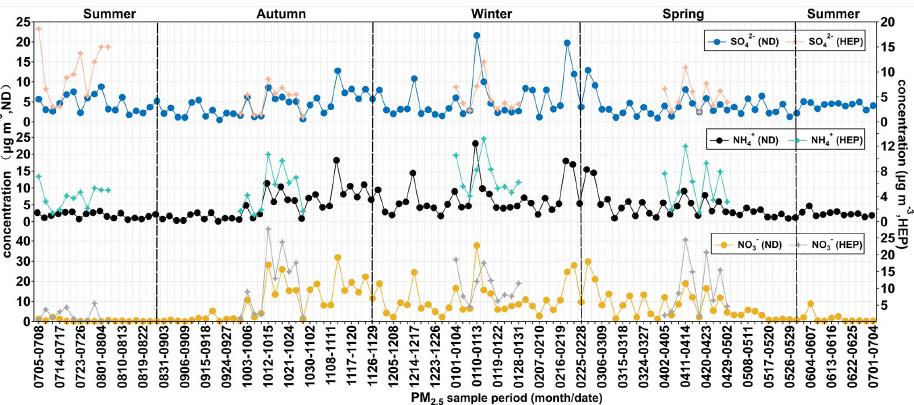
Figure 10. Temporal variations in concentrations (µgm − 3 ) of secondary ionic species in PM 2 . 5 at ND (solid dots) and HEP (solid stars) in Tianjin during the campaign period (2018–2019).